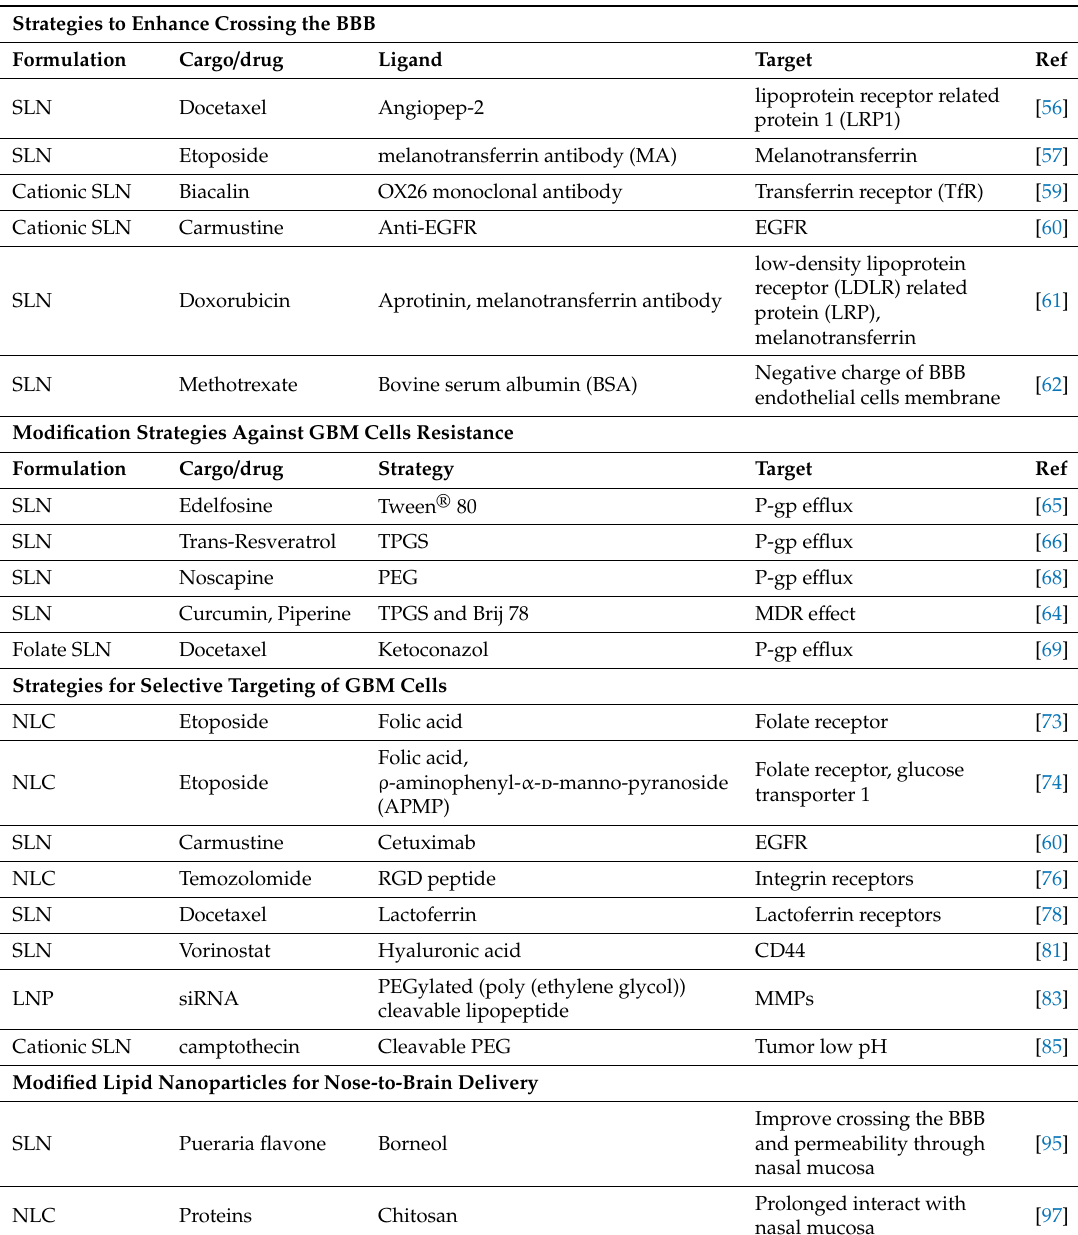
Table 1. SLNs and NLCs for enhanced treatment of